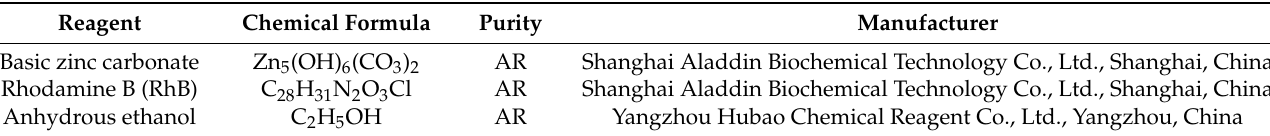
Table 7. Experimental